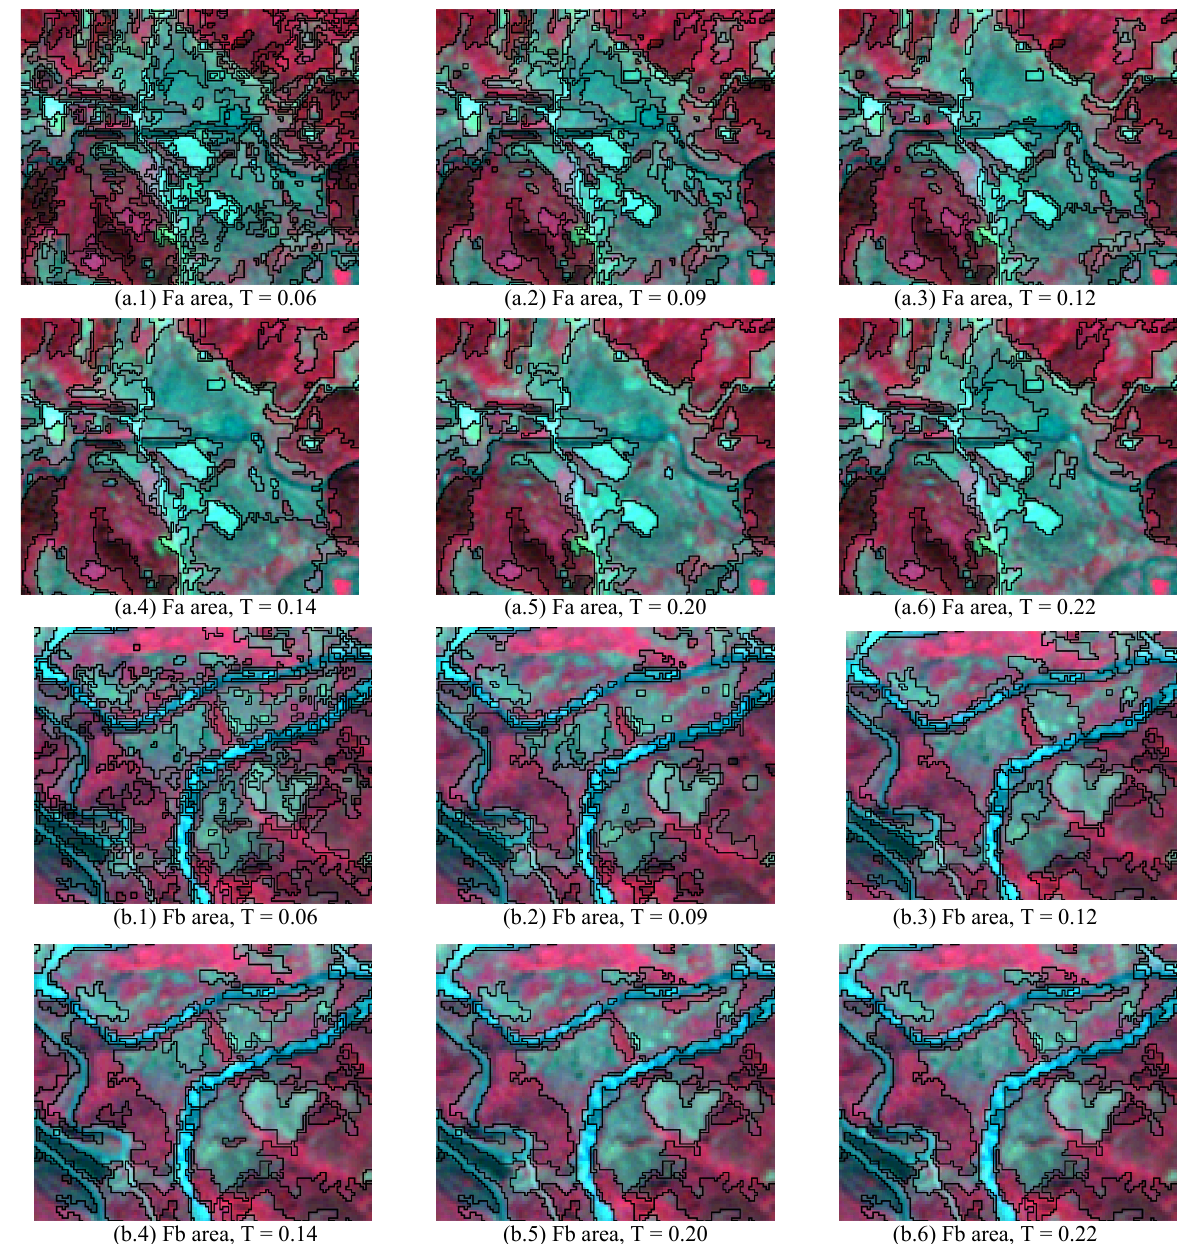
Figure 3. Segmentation boundaries of Fa and Fb areas in six selected thresholds